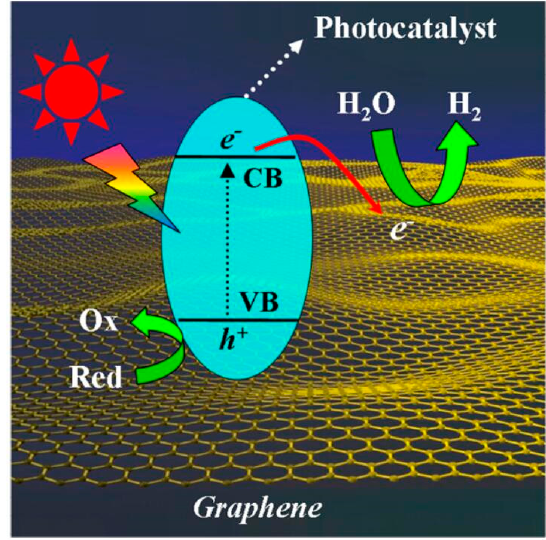
Figure 3. Proposed mechanism of graphene-based photocatalysts. Reproduced with permission from Reference [56]; copyright (2013), American Chemical Society.